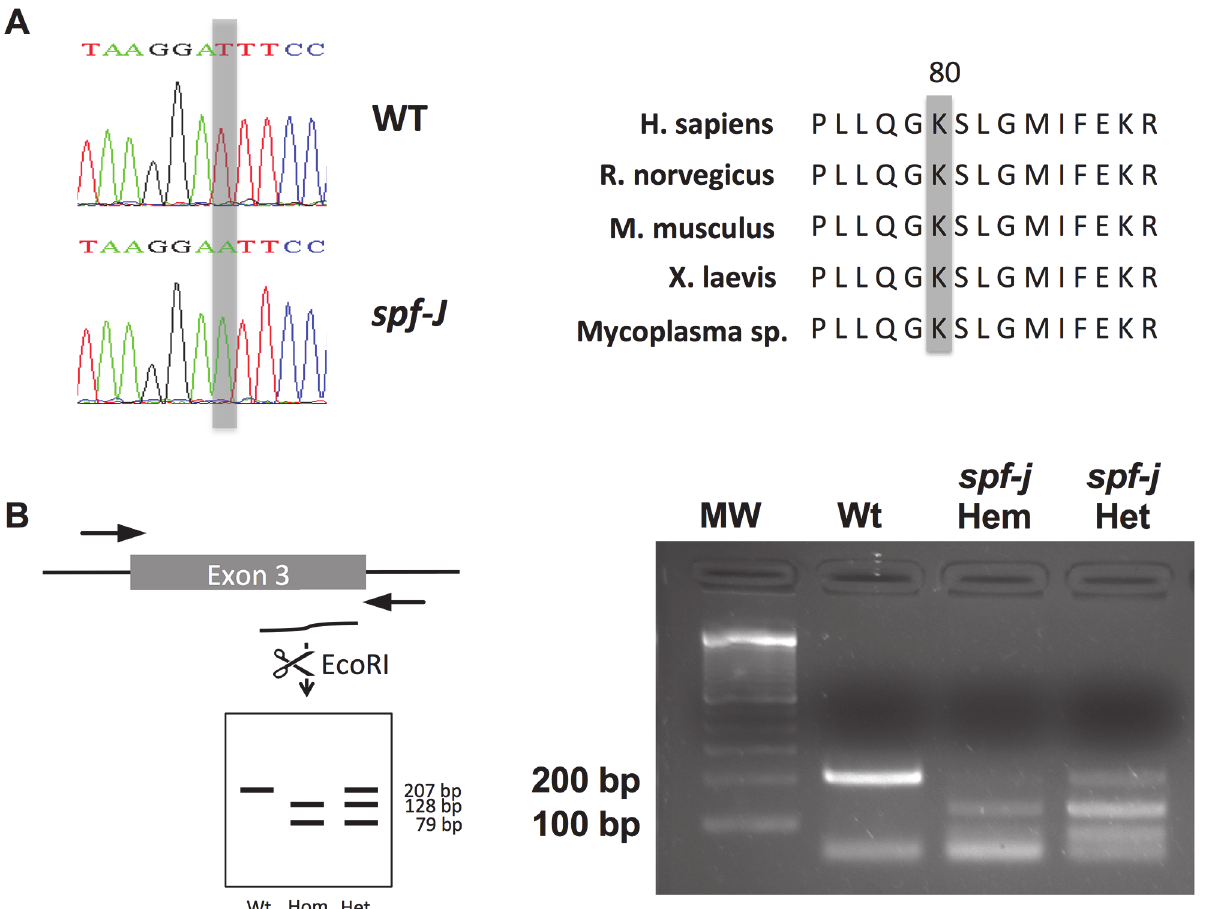
Figure 1. Identification of the molecular lesion in spf-J . A) PCR amplification of gDNA from spf-J revealed a transversion mutation in exon 3 leading to an asparagine replacement of a conserved lysine residue at position 80 (K80N). B) Genotyping assay of female spf-J with PCR amplification followed by digestion with EcoRI. Hem – hemizygote, Het –